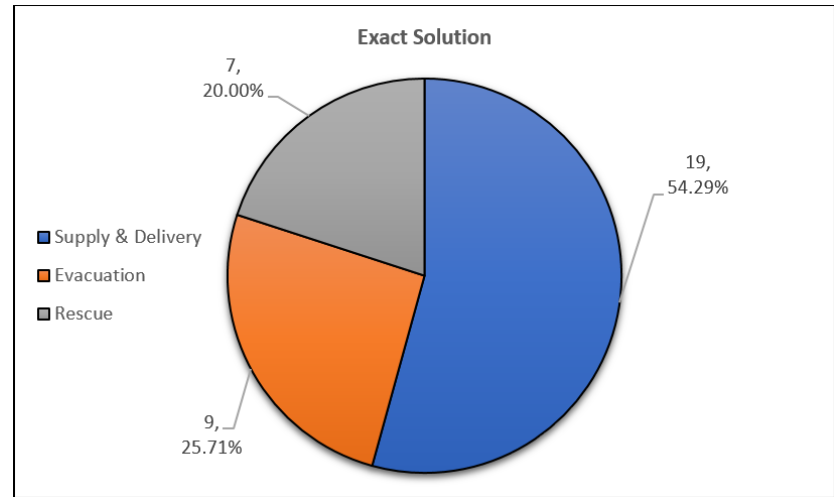
Figure 28. Selected Humanitarian Operation based on Exact Solution.